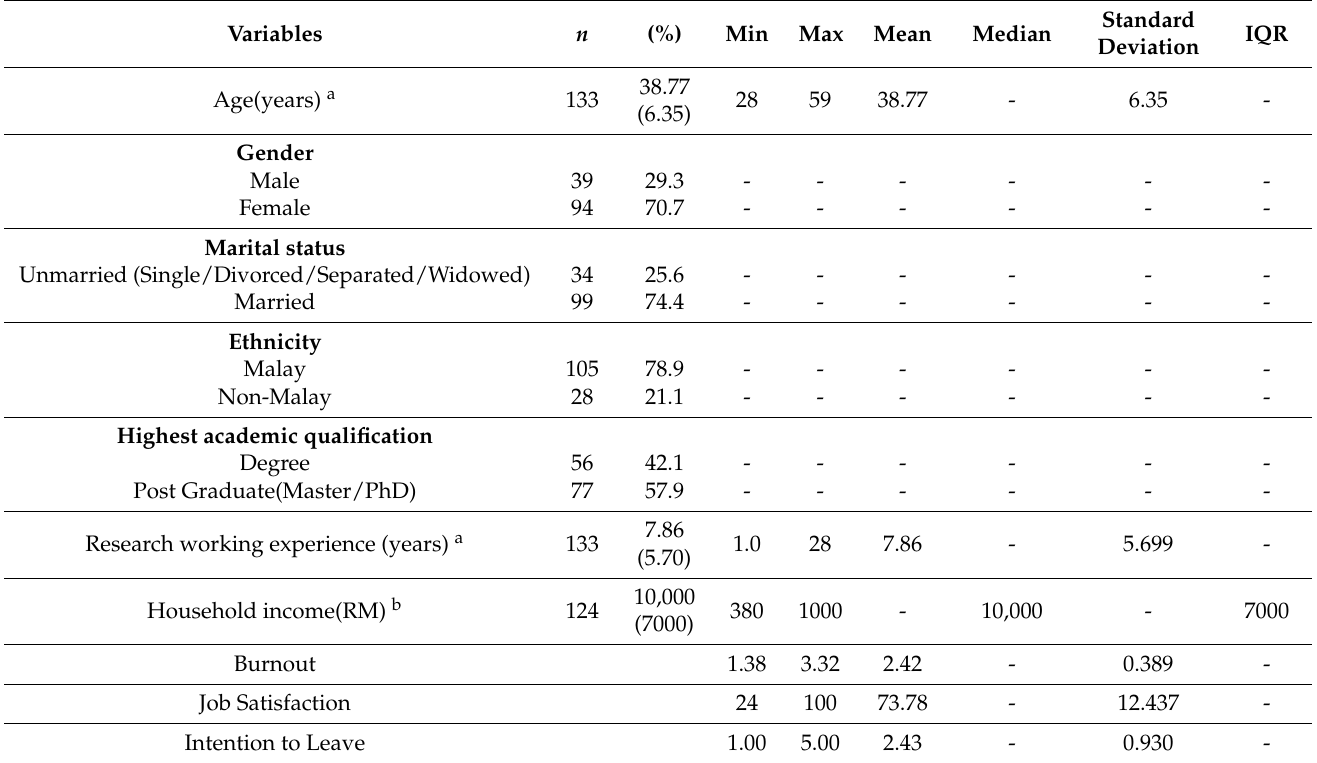
Table 1. Sociodemographic Characteristics of the Respondents and Summary of Descriptive Statistical Results ( n = 133).